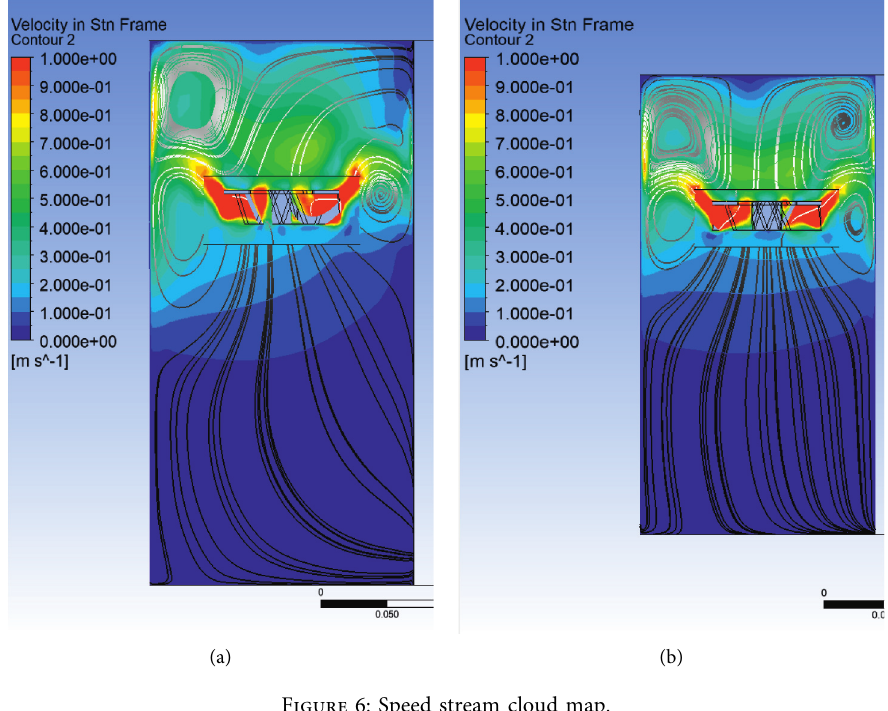
Figure 6: Speed stream cloud map.